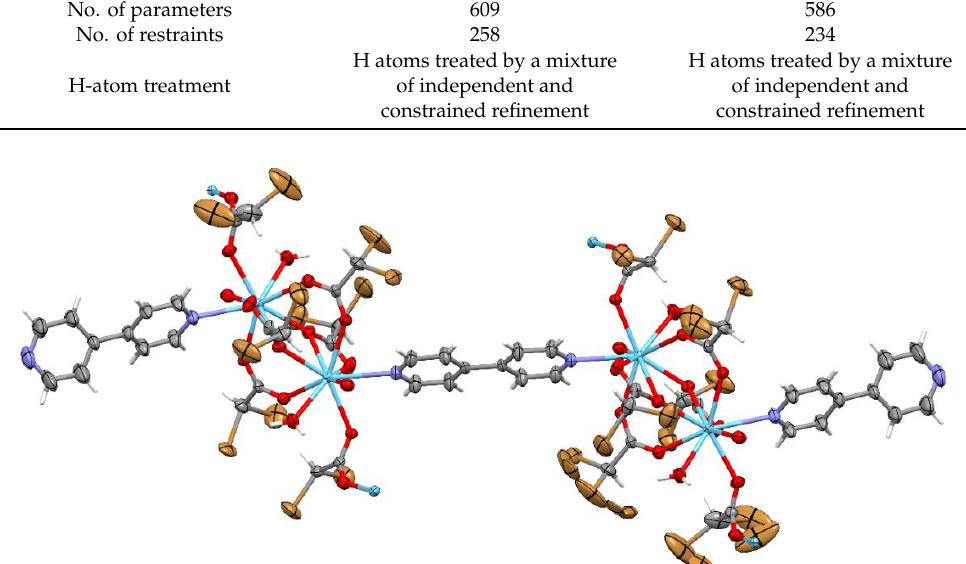
Figure 2. The molecular structure of the complex with La(III) (compound 1) showing the atom- labelling schemes.